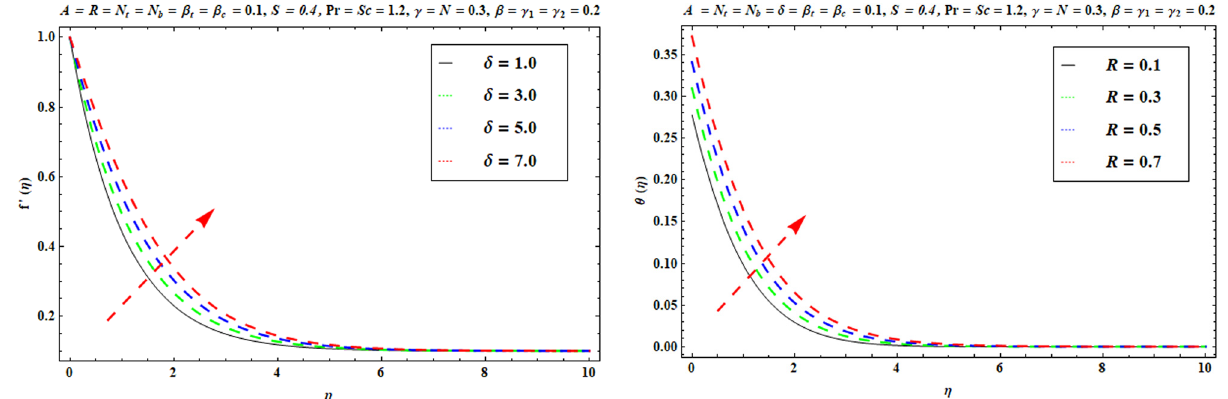
Figure 10: θ η ( ) versus R .